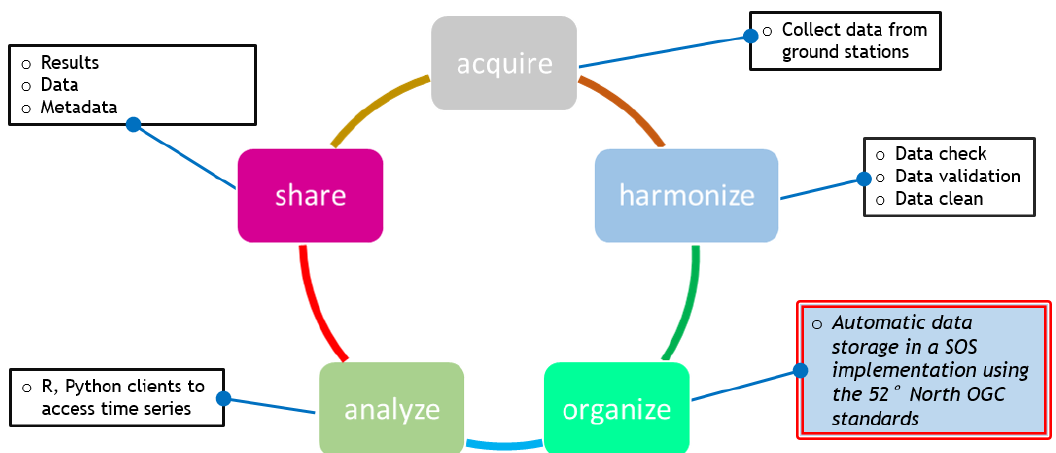
Figure 1. The adopted data life cycle for implementing our methodology. In the double-framed